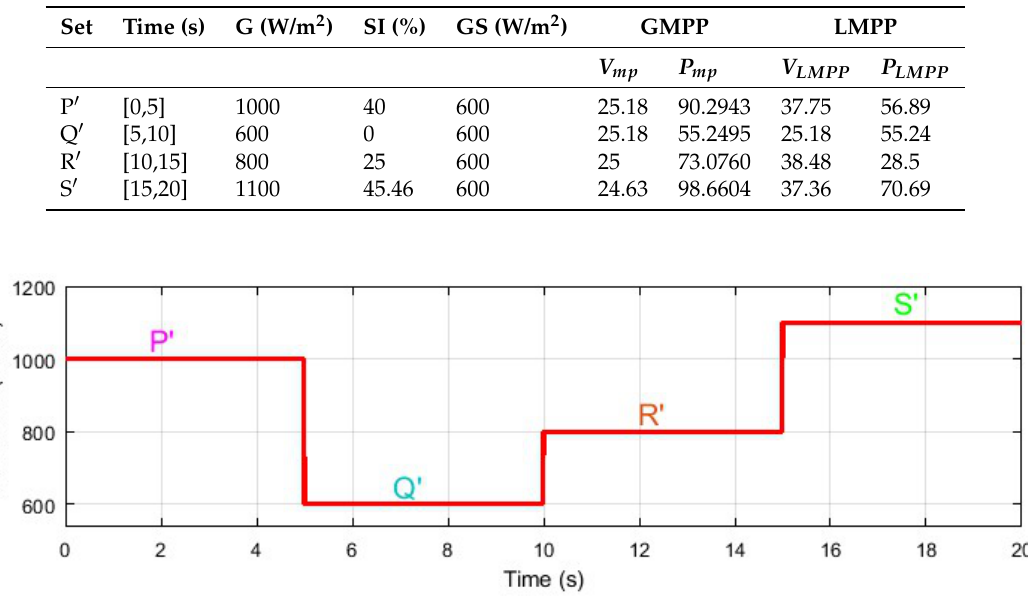
Figure 14. irradiance values affecting 75% of the